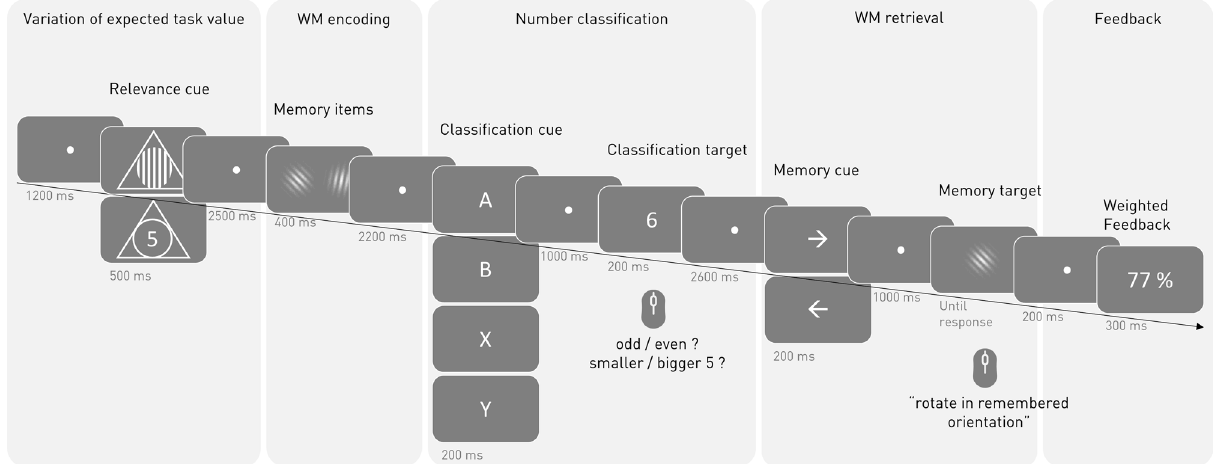
Figure 1. Schematic illustration of a trial’s sequence. Each trial consisted of five parts depicted here by five bright grey columns. The trial started with one of two possible relevance cues indicating which of two tasks would be more important and thus should be focused on during the upcoming trial. Then, participants performed a cued number classification in the retention interval of a working memory task. In the number classification task, participants classified the classification target (one of the digits 1, 2, 3, 4, 6, 7, 8, 9) via left or right button press. The classification cue indicated which of two classifications should be done. In the working memory task, participants used their mouse to rotate a Gabor patch with random orientation (the memory target) in a previously remembered orientation of a memory item. In each trial, two memory items are shown, one on the left and one on the right side of the screen. The memory cue pointed to the side of the memory item which should be used in the memory task. At the end of each trial, participants perceived feedback based on their performance in both tasks. Performance in the more important task was weighted three times stronger than performance in the less important task. The bright grey numbers under the schematic screens indicate stimuli’s duration on screen. WM working